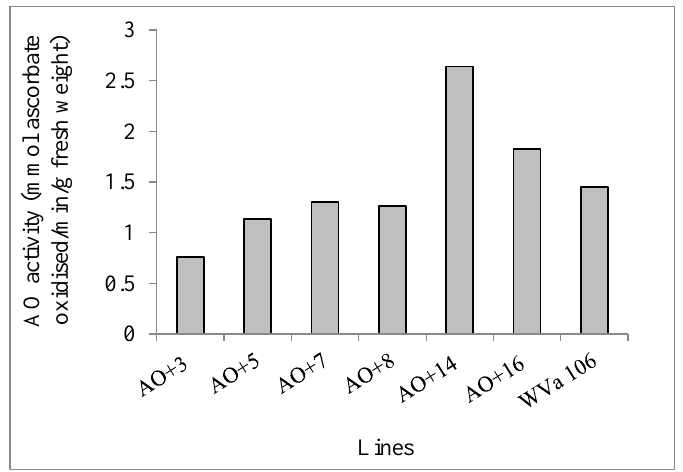
Figure 1. Ascorbate oxidase activity of primary transformants. Activity was measured in leaf tissue from individual primary transformants and expressed as millimoles of ascorbate oxidized at 265 nm per minute per gram of fresh weight of tissue.